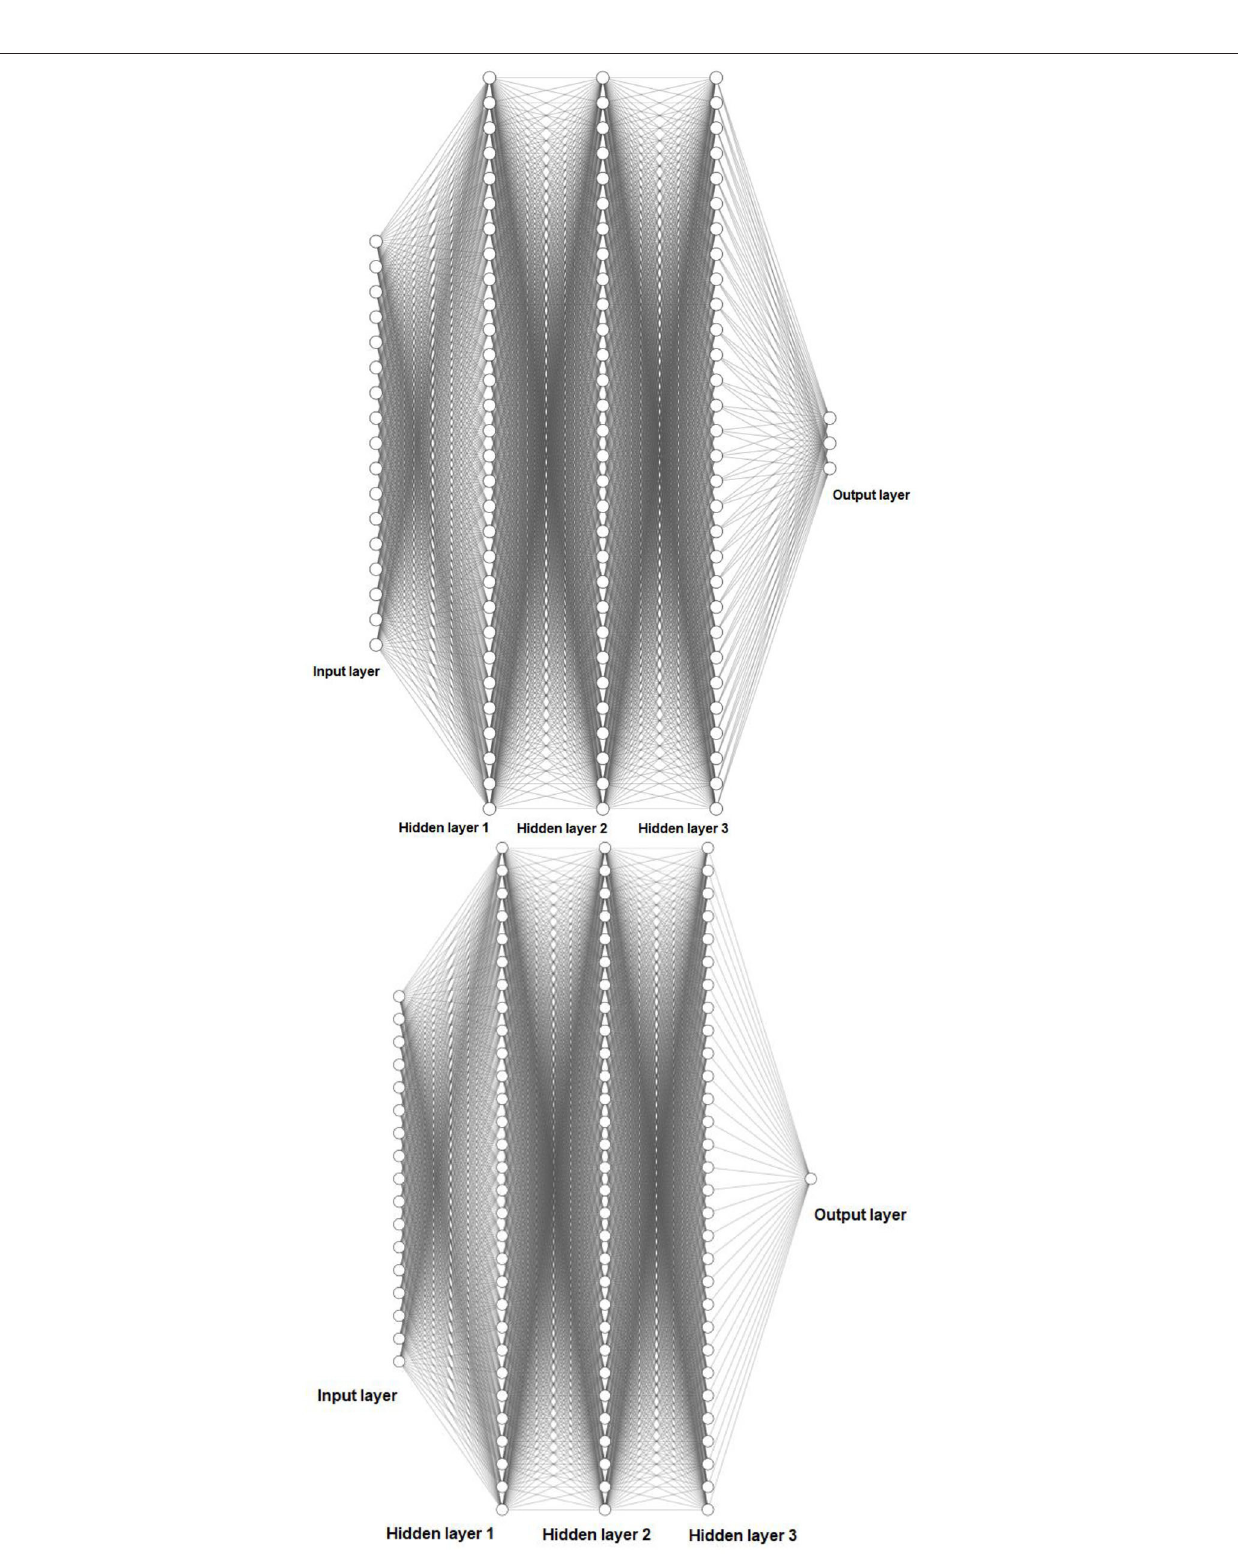
Frontiers in Psychology |